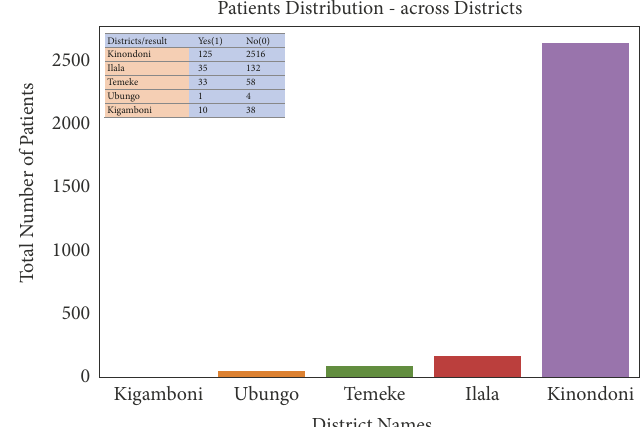
Figure 4: Patient distribution across districts.